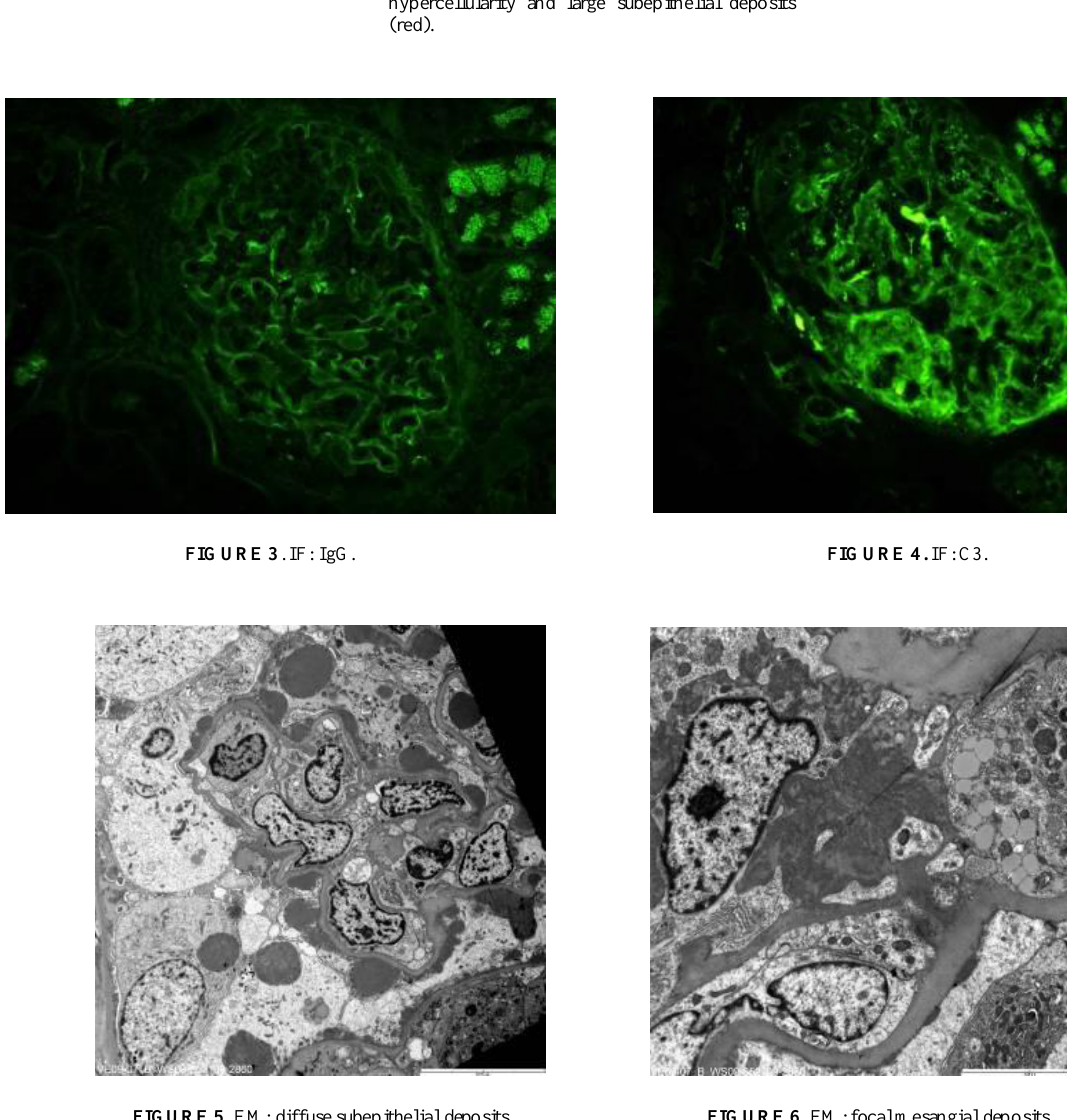
FIGURE 5. EM: diffuse subepithelial deposits. FIGURE 6. EM: focal mesangial